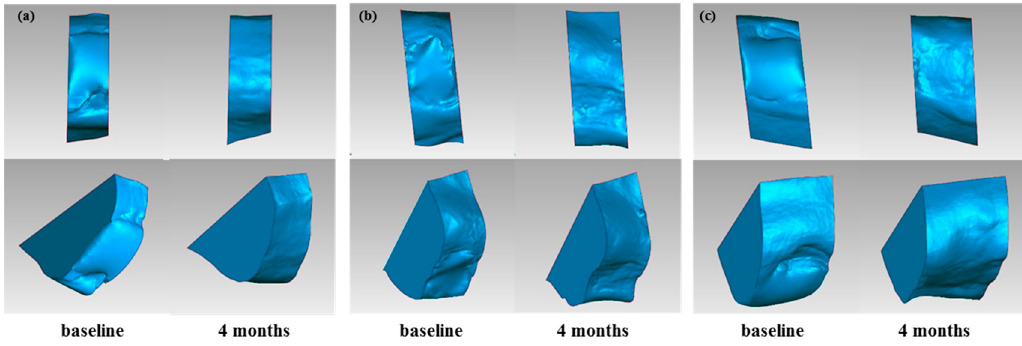
Figure 3. Soft tissue volume calculation. The scanned images were superimposed for volumetric quantification of soft tissue alteration. The three-dimensional rendered images of occlusal view were cropped and measured in cubic mm (mm 3 ) via Geomagic Studio Software (3D system Inc., Rock Hill, SC, USA): ( a ) Group A; ( b ) Group B; ( c ) Group C.